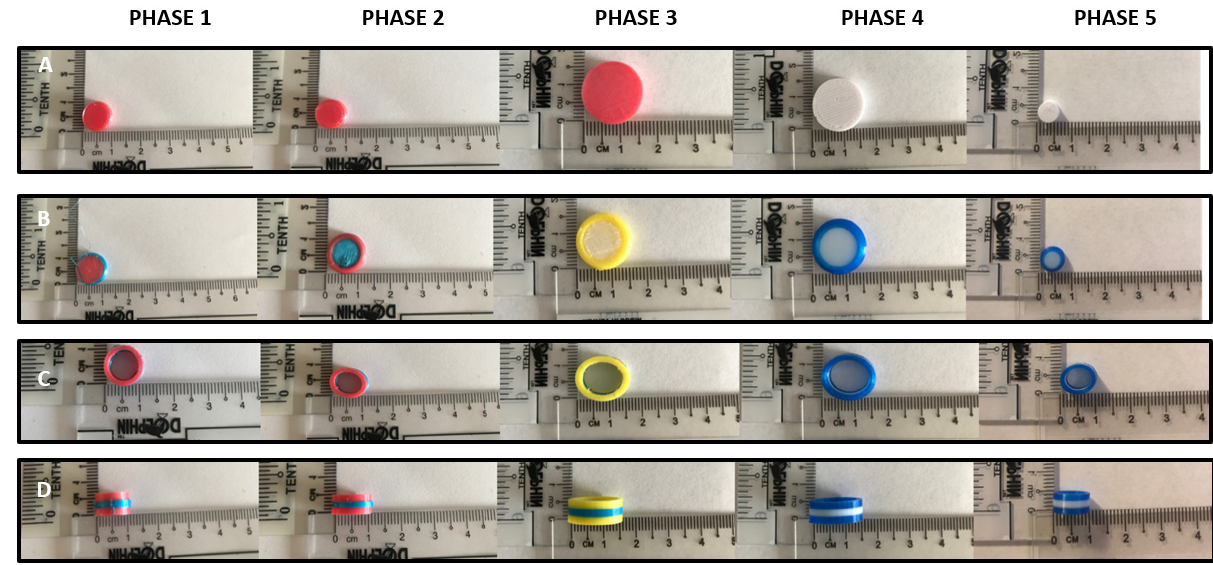
Figure 3. The 2D images of remotely 3D ‐ printed design 4, phases 1 to 5. Table 4. Physical properties of 3D ‐ printed gummy bear shape tablet (design 4). Data for diameter, Figure 2. Figure 2. The 2D images of remotely ‐ 3D ‐ printed model designs ( A ) 1, ( B ) 2, ( C ) 3—top Figure 2. The 2D images of remotely-3D-printed model designs ( A ) 1, ( B ) 2, ( C ) 3—top view and length, and thickness represent the mean ± standard deviation (SD), where n = 2. view and ( D ) 3—side view phases 1 to 5. ( D ) 3—side view phases 1 to 5. Table 3. Physical properties of remotely ‐ 3D ‐ printed model designs 1 to 3. Data for diameter, length, and thickness represent the mean ± standard deviation.